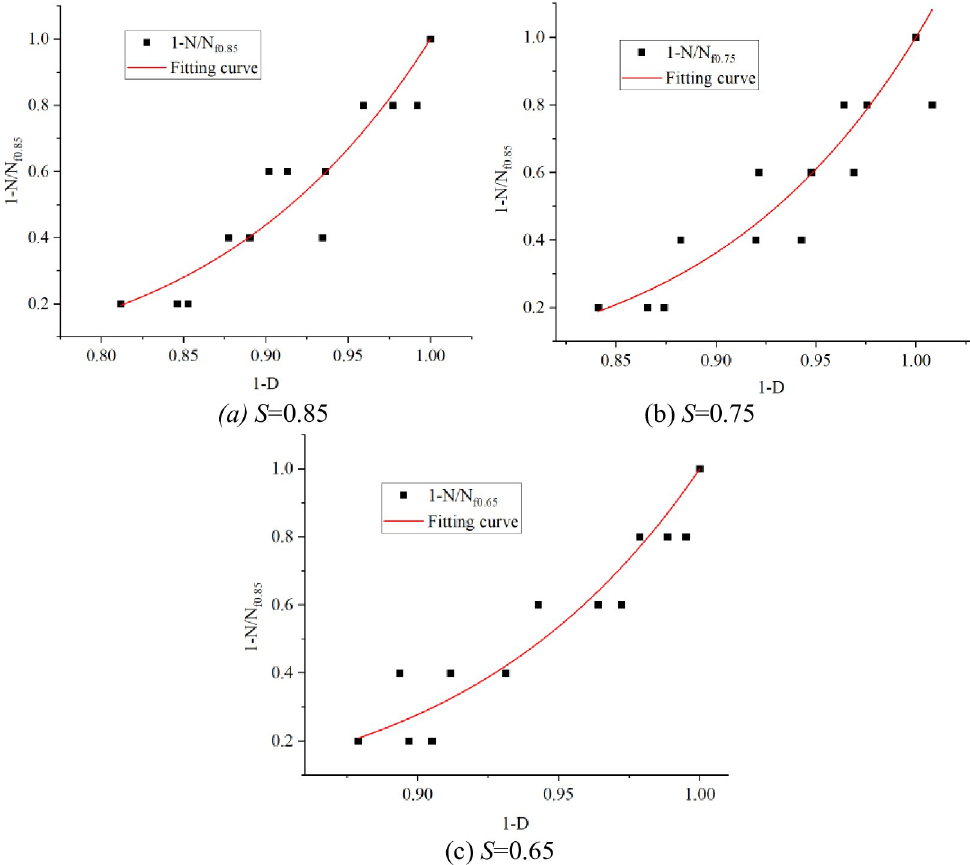
Fig 6. Relative damage strength at different stress levels and test of evolution equation. (a) S = 0.85. (b) S = 0.75. (c) S = 0.65.